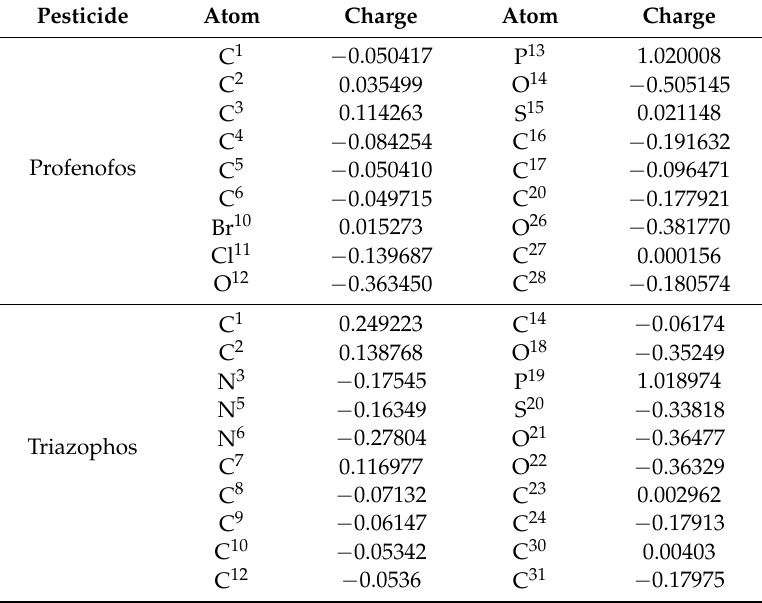
Table 2. Mulliken atomic charges of profenofos and triazophos molecule. Pesticide